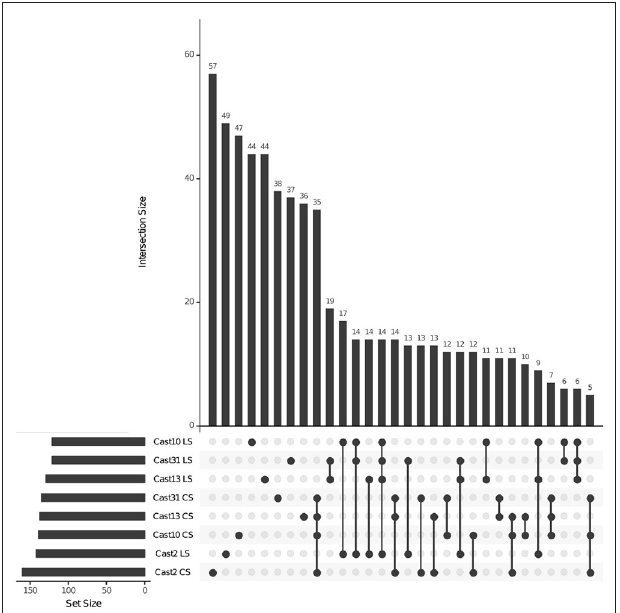
FIGURE 8 | Loci lost or silenced across T. castellanus individuals. Set IDs represent samples where either T. crocifolius (C) or T. lamottei (L) homoeologs are lost (L) or silenced (S). Overlapping sets are indicated by filled circles, and the number of loci within that intersection may be seen directly above in the bar chart. The total sample sizes are found in the left bar chart and correspond to the adjacent sample. As expected, there should be no overlap across T. crocifolius and T. lamottei